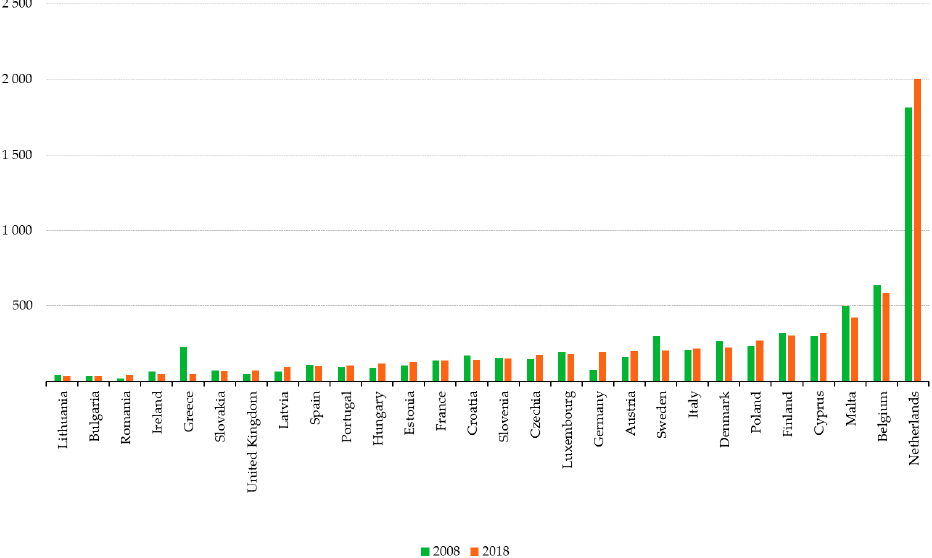
Figure 4. Energy consumption in agriculture per hectare of arable land in kgoe. Reproduced from [45], Eurostat: 2021.